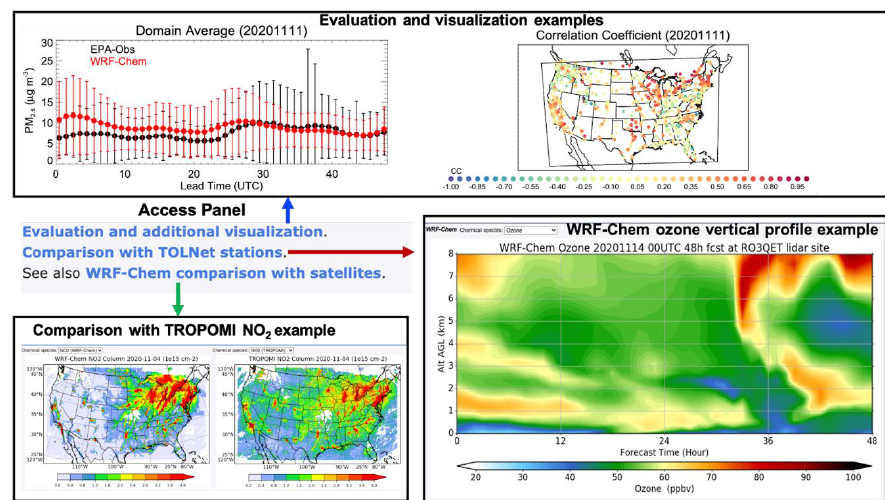
Figure 3. A snapshot of the information dissemination system showing the access panel with the blue, red, and green arrows pointing to examples of additional evaluation and visualization, Weather Research and Forecasting model coupled with Chemistry (WRF-Chem) ozone vertical profile at a Tropospheric Ozone Lidar Network (TOLNET) site, and comparison with the Tropospheric Monitoring Instrument (TROPOMI) tropospheric column NO 2 retrievals. EPA: environmental protection agency. Figure based on [29].